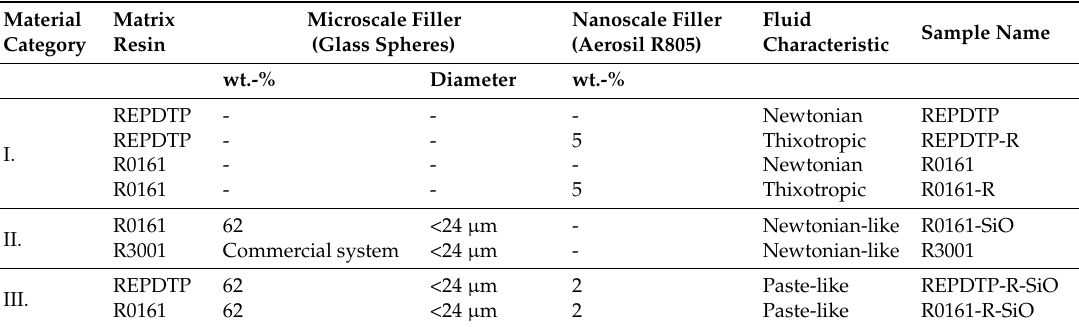
Table 1. Material composition